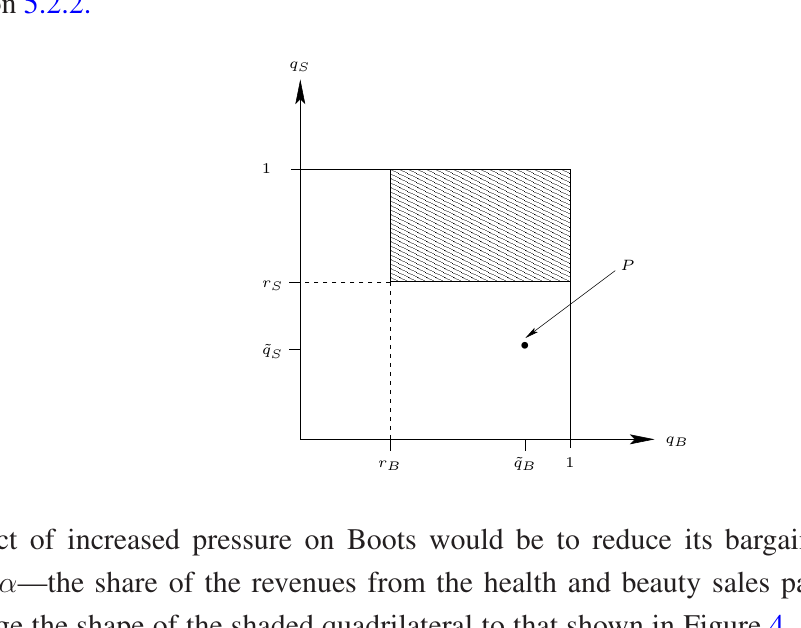
Figure 3. Ally-Ally is not a Nash equilibrium when α = 0 ; the point, P , is referred to in Section 5.2.2.